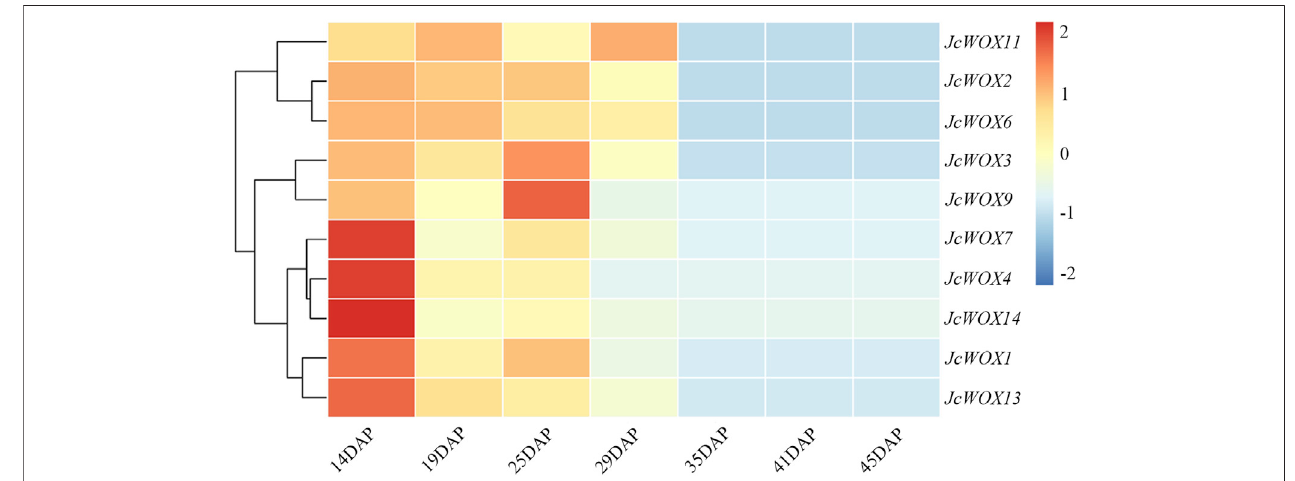
FIGURE 6 | Expression patterns of 10 JcWOX genes during seven seed developmental stages.